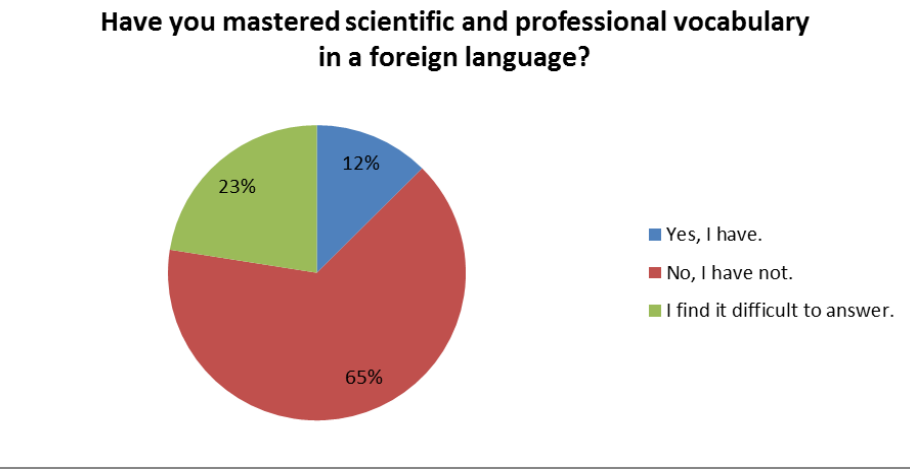
Fig. 1. Mastery of scientific and professional